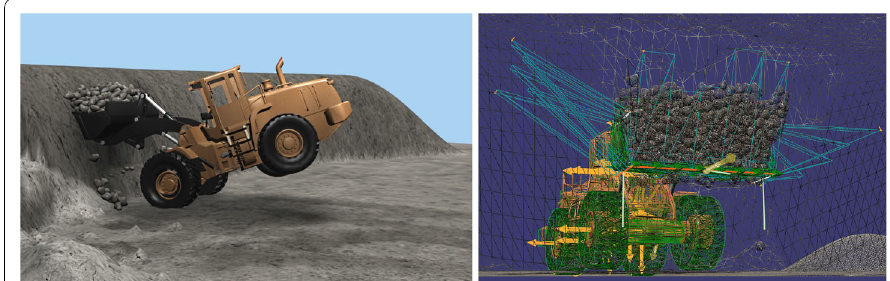
Table 2 Performance analysis of the excavation test involving N rb rigid bodies and N p particles N rb N p N rb Multiscale 8 950